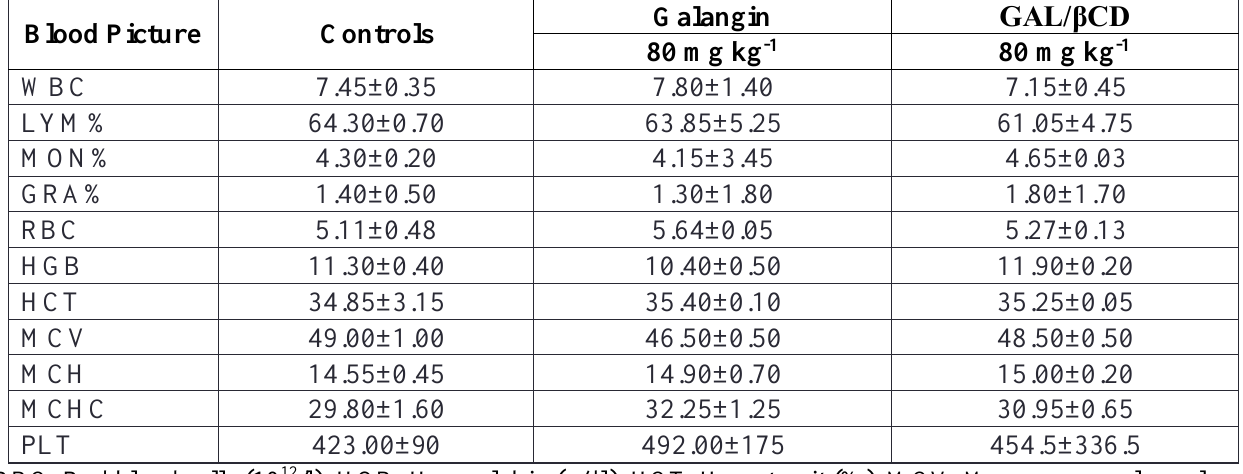
Table 2: Hematological parameters of male mice submitted to treatment with pure galangin and galangin / β- cyclodextrin for 14